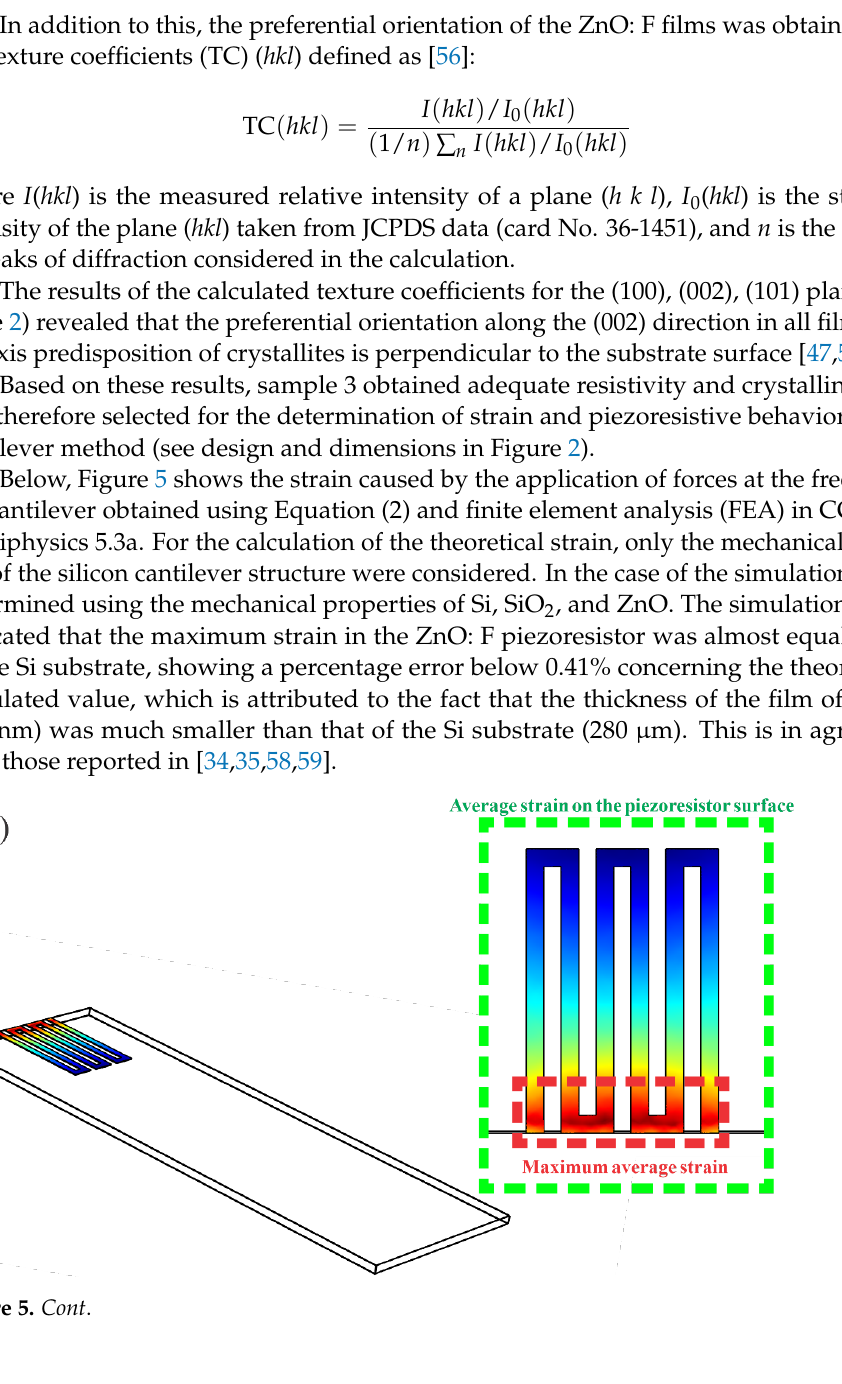
Figure 5. ( a ) Results of the finite element analysis (FEM) of the piezoresistor strain caused by the application of forces at the free end of the cantilever; ( b ) average strain extracted via simulation of the ZnO:F patterned surface versus theoretically calculated strain.